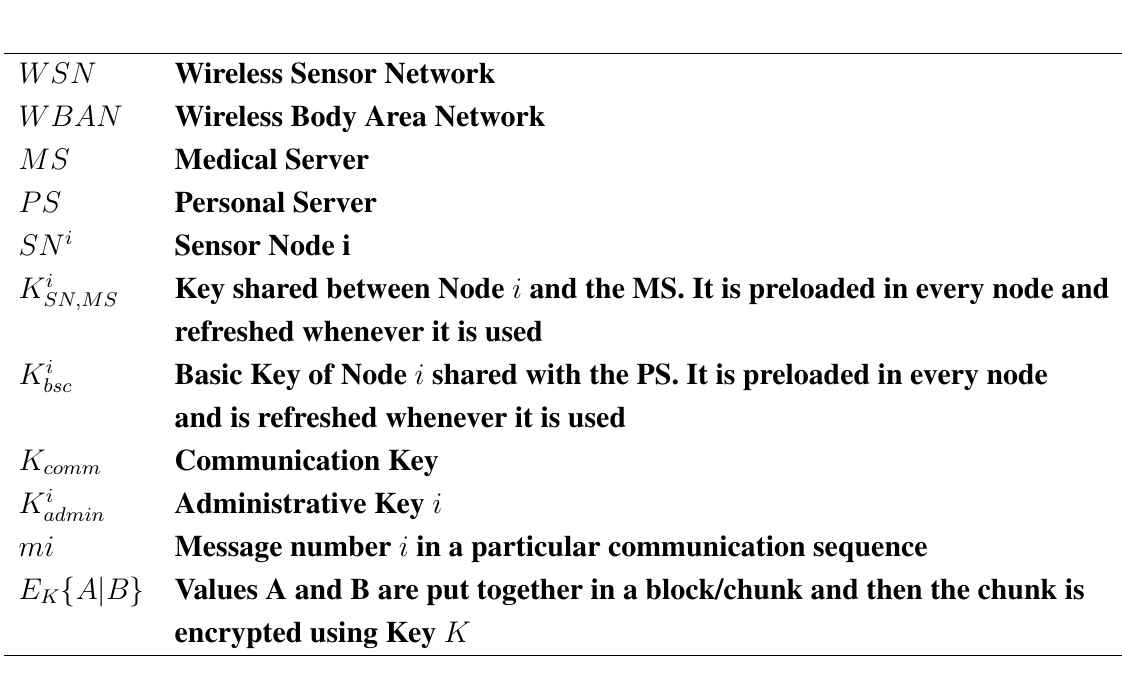
Table 3. List of Used